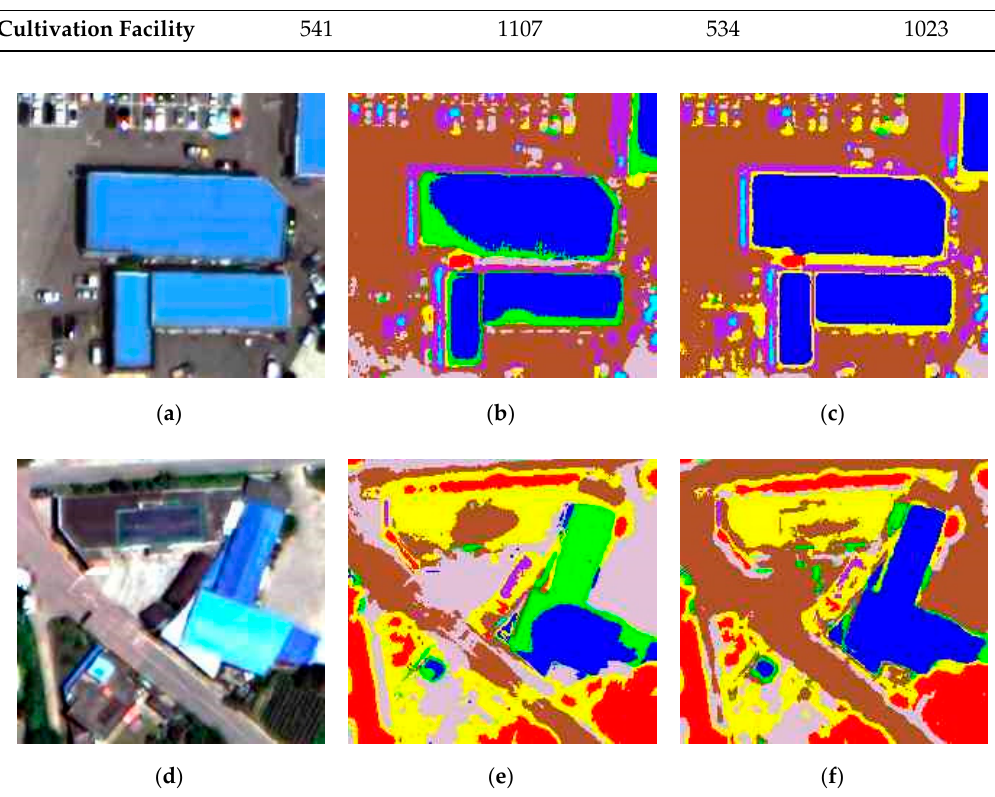
Figure 8. Comparison of classification results: ( a ) RGB image of site 1, ( b ) classification result using only VNIR bands, ( c ) classification result using VNIR and SWIR bands, ( d ) RGB image of site 2, ( e ) classification result using only VNIR bands, ( f ) classification result using VNIR and SWIR bands.